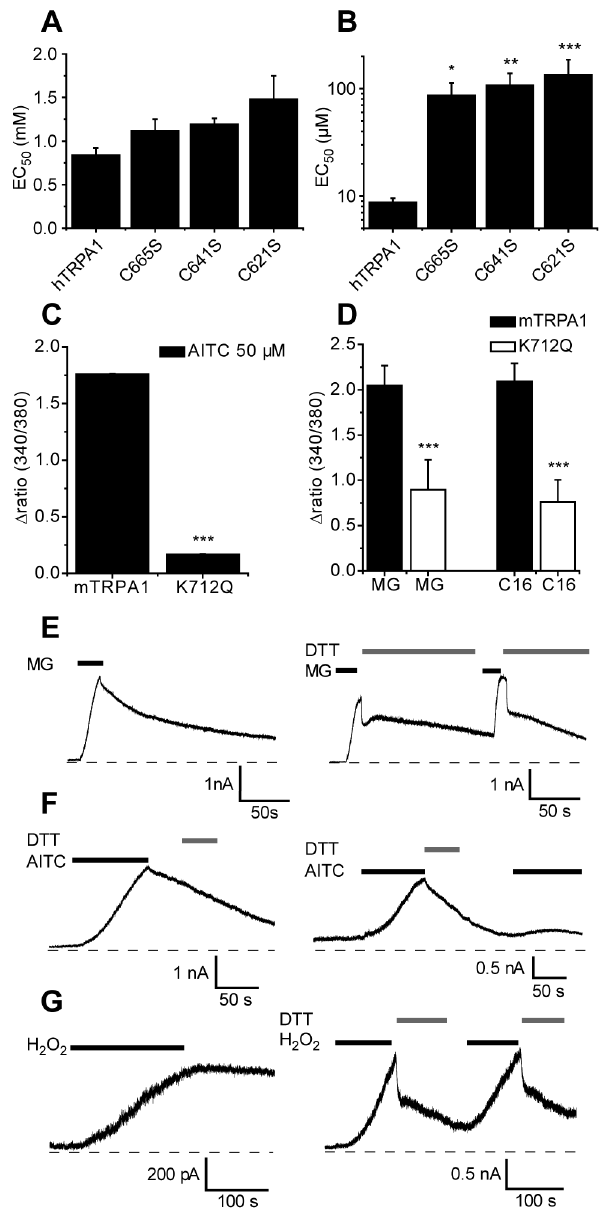
Figure 4. Methylglyoxal is a reversible TRPA1 agonist. The cysteine substitutions C665S, C641S and C621S (in human TRPA1) do not significantly affect responses evoked by MG (A), but dramatically reduce the sensitivity to AITC (B). (C) The lysine substitution K712Q (mouse TRPA1) reduced [Ca 2 + ] i -responses evoked by AITC (50 m M). (D) The K712Q mutation reduced the amplitude of [Ca 2 + ] i -responses evoked by MG (2 mM) and D 9 -tetrahydrocannabiorcol (20 m M; C16) in individual CHO cells (n=22–64). (E) Outward TRPA1 current responses ( + 60 mV) evoked by MG (1 mM) in CHO cells decay relatively slowly when MG is removed (recorded under Ca 2 + -free conditions). Application of DTT (2 mM) produces a rapid, partial current inactivation. (F) Currents evoked by AITC (50 m M) under the same conditions inactivate relatively slowly, but are resistant to DTT and leave TRPA1 refractory to stimulation. (G) Currents elicited by the oxidant H 2 O 2 (5 mM) remain at a stable level after removal of H 2 O 2 , but are rapidly and reversibly inactivated by DTT. Data were analyzed by ANOVA followed by Dunnett’s post-hoc test (panel B) or by t-test (*P , 0.05, **P , 0.01, ***P , 0.001 compared to the wildtype